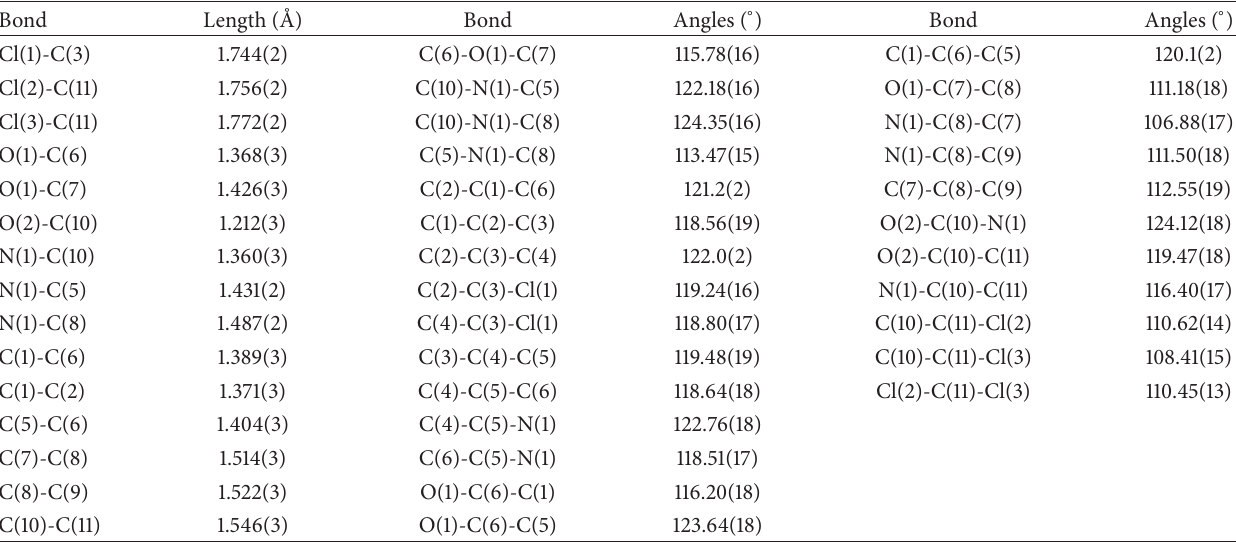
Table 2: Selected bond lengths (˚A) and angles ( ∘ ) for the title compound.